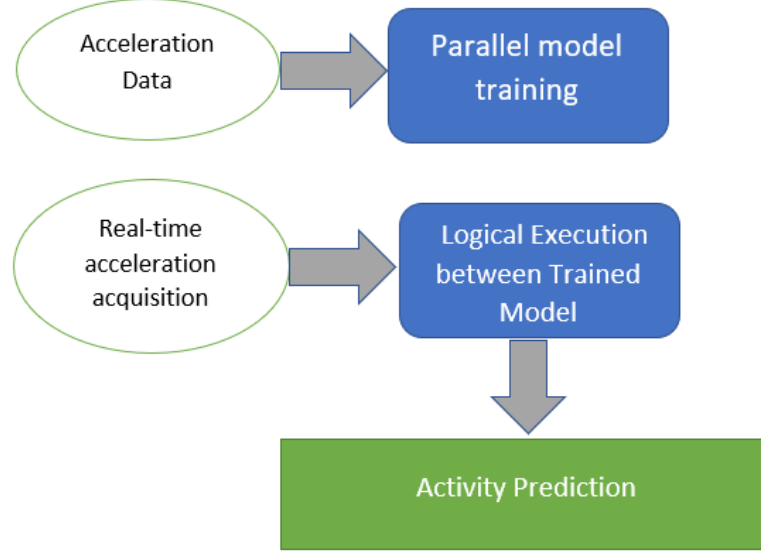
Figure 4. System overview diagram.